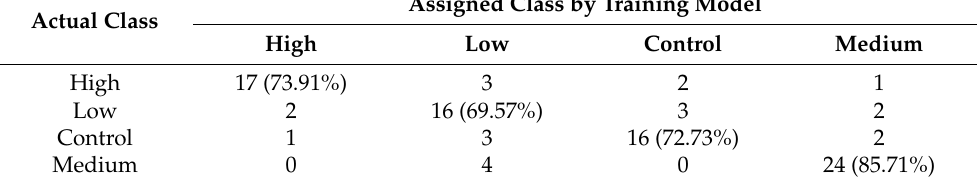
Table 1. Linear discriminant classification of hyperspectral data (450–2400 nm) of whitefly infested soybean leaves (n = 160). Independent validation was carried out with 48 samples and classified with 75.48%